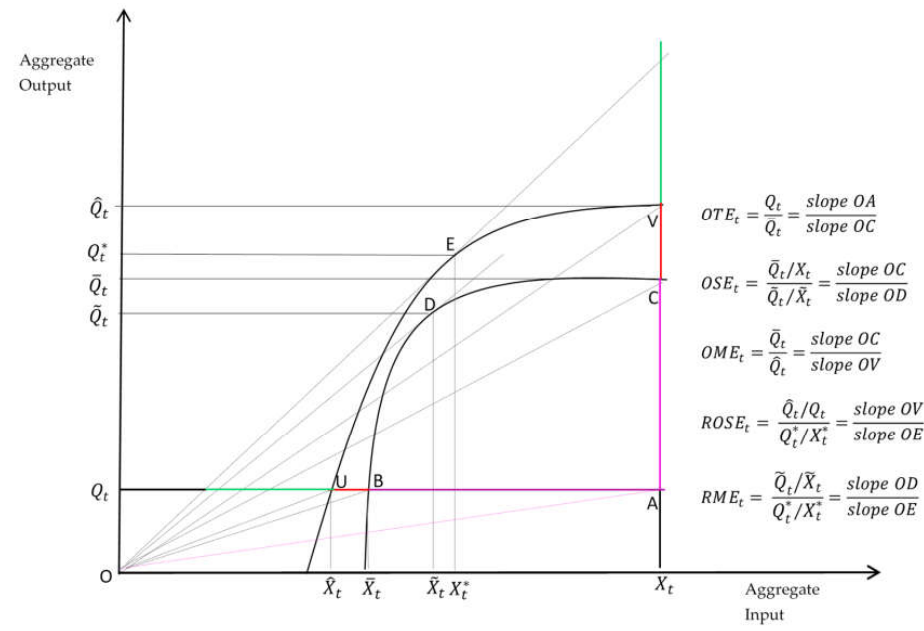
Figure 1. Technical, scale and mix e ffi ciency of a multi-input multi-output firm.